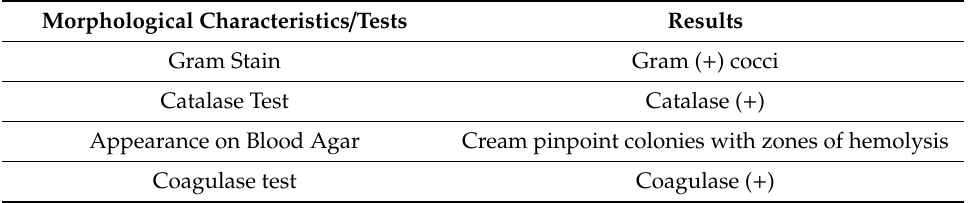
Table 1. Morphological, coagulase and catalase tests done on milk samples from the Agouti ( D. leporina